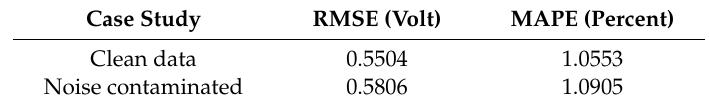
Table 2. Numerical evaluations of the step response achieved by the proposed method.